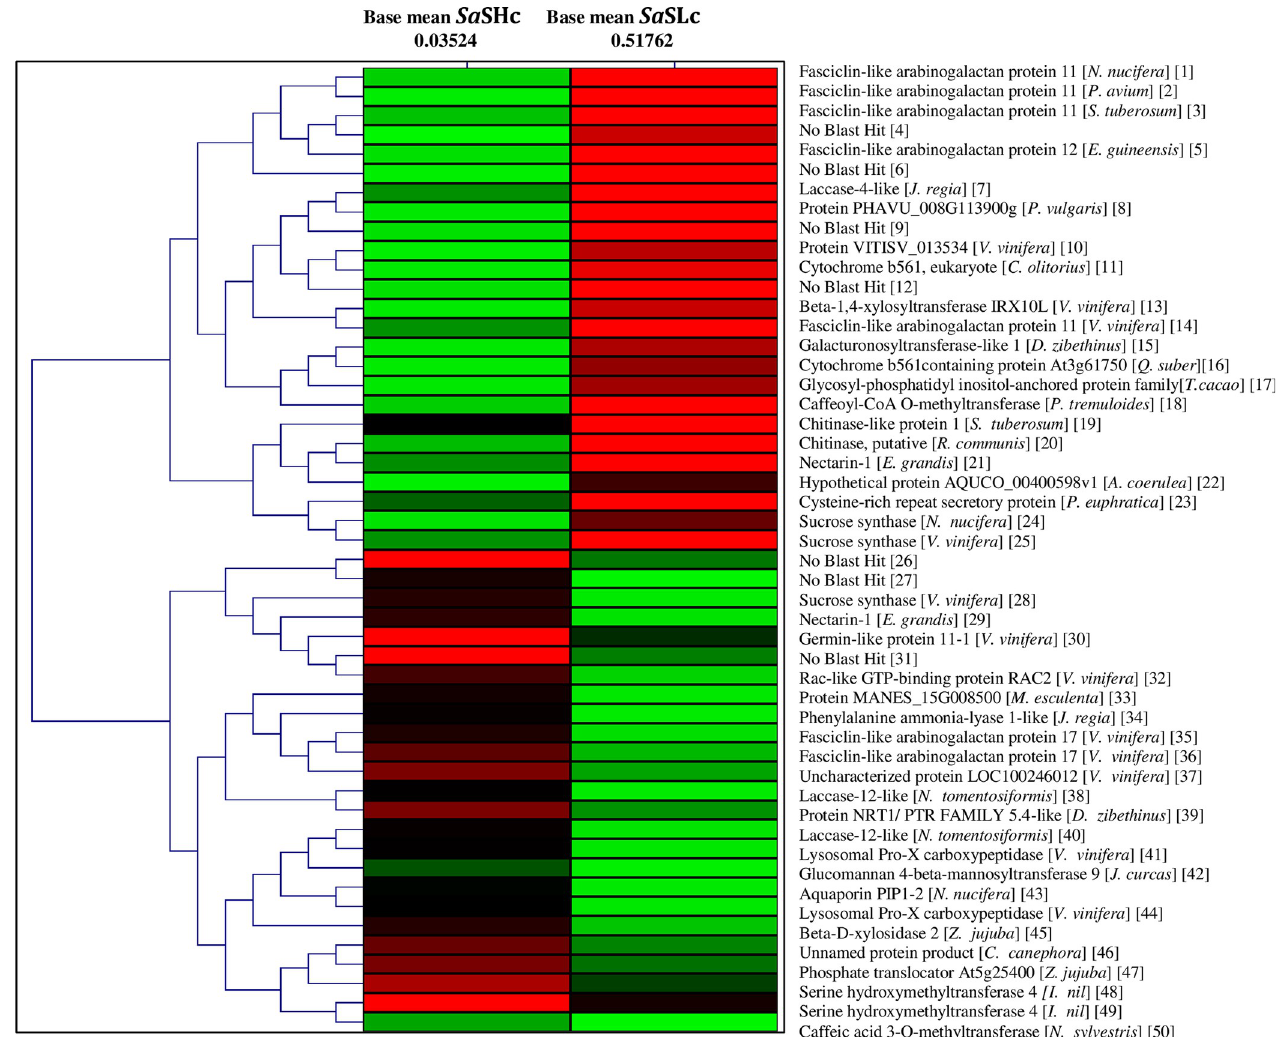
Fig 7. Validation of relative gene expression levels of differentially expressed genes by qRT-PCR. Purple and blue lines represent the RNA-Seq results, while red and green bars represent the qRT-PCR results. The error bars indicate the standard deviation.